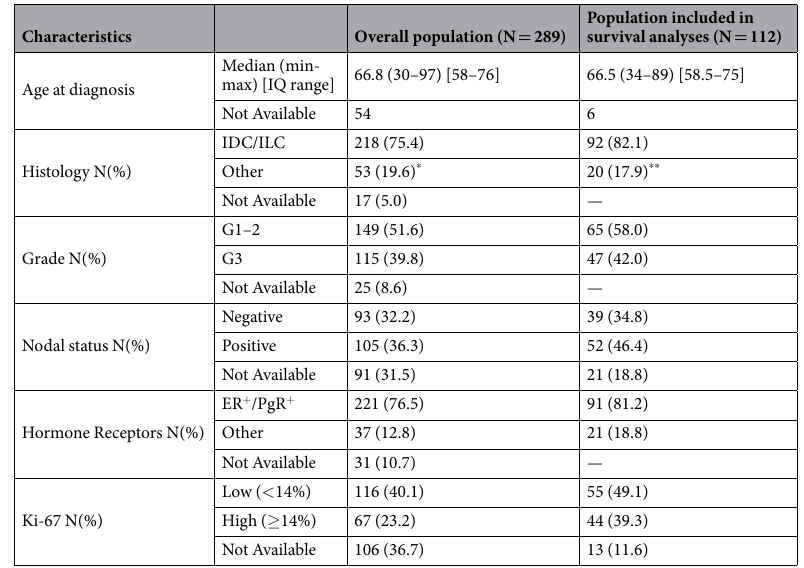
Table 1. Baseline characteristics of MBC patients included in this study. * 10 Adenocarcinoma, 5 Intraductal papillary carcinoma, 10 Papillary carcinoma, 11 Mucinous carcinoma, 5 Ductal carcinoma in situ , 6 Mixed, 1 Abbreviations: IDC: Invasive Ductal Carcinoma, ILC: Invasive Lobular